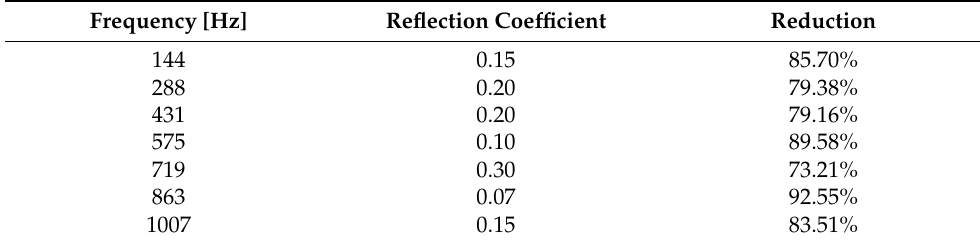
Table 2. Experimental reflection coefficients in the active case.